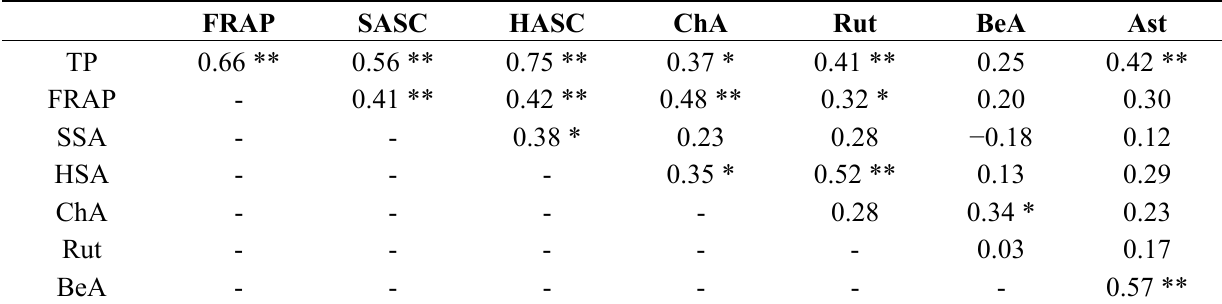
Table 3. Coefficients of Pearson’s correlation test between experimental parameters.